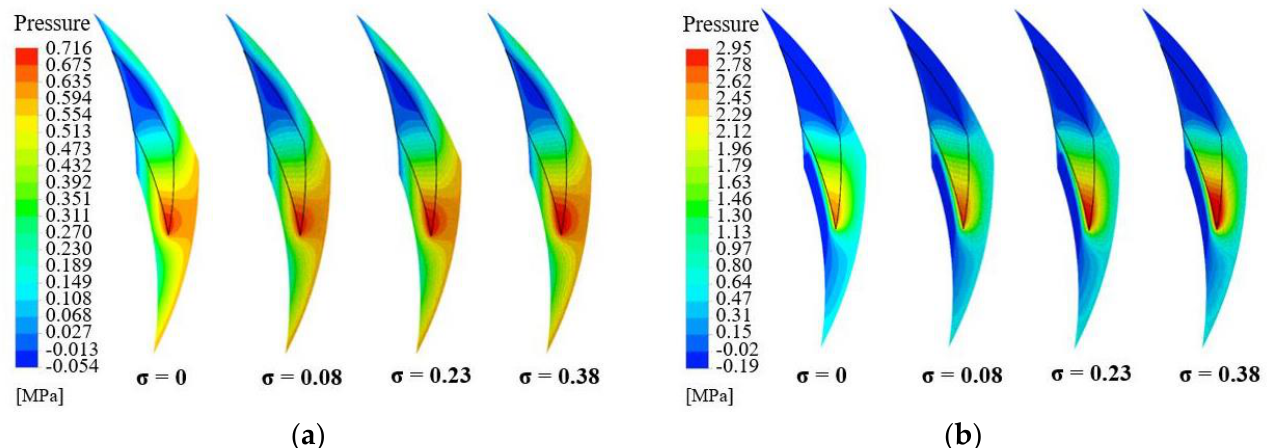
Figure 15. Pressure distribution under different roughness values of the stationary ring surface: ( a ) n = 1000 rpm, ( b ) n = 10,000 rpm.